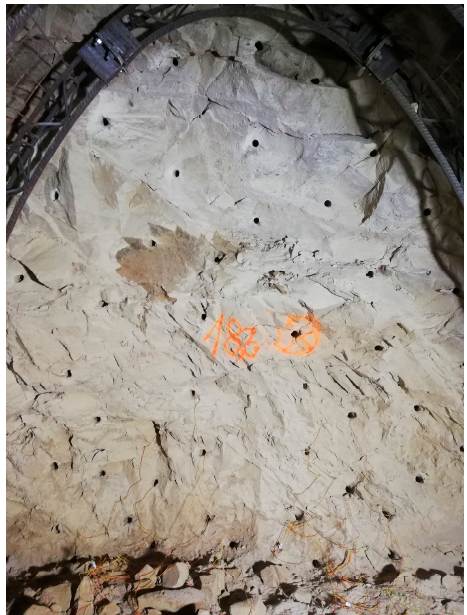
Figure 9. A drilled and partially charged